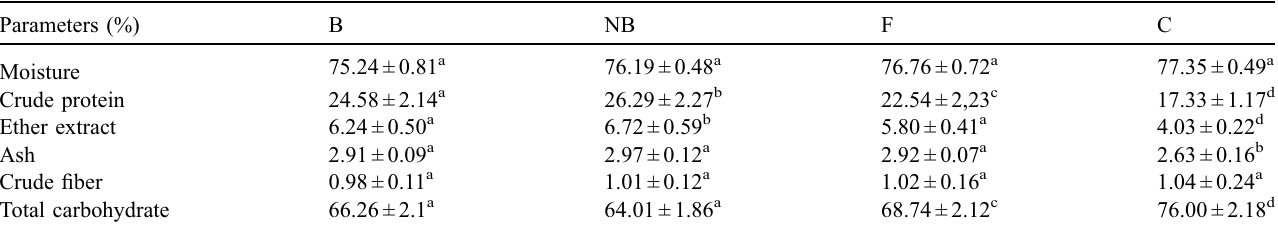
Table 5. Proximatefs composition (% dry matter basis) of L. vannamei cultured in different pond treatments (mean ±standard error; n = 3). Parameters (%)